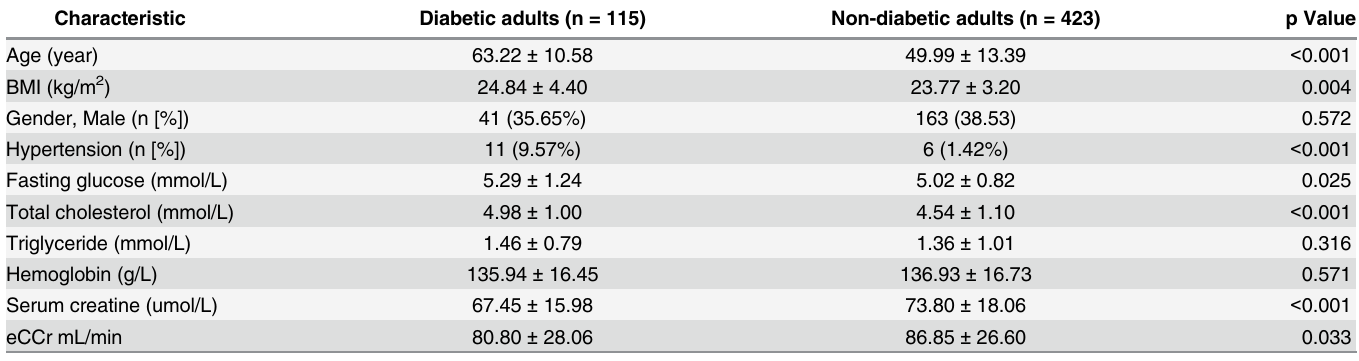
Table 1. Mean demographic in diabetic and non-diabetic adults a .